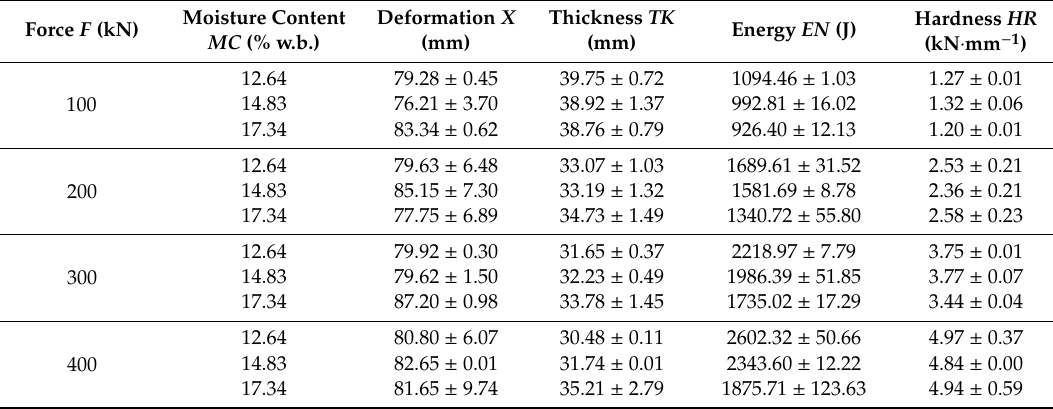
Table 8. Deformation, thickness, energy, and hardness of ground hazelnut husks with forces and moisture contents.